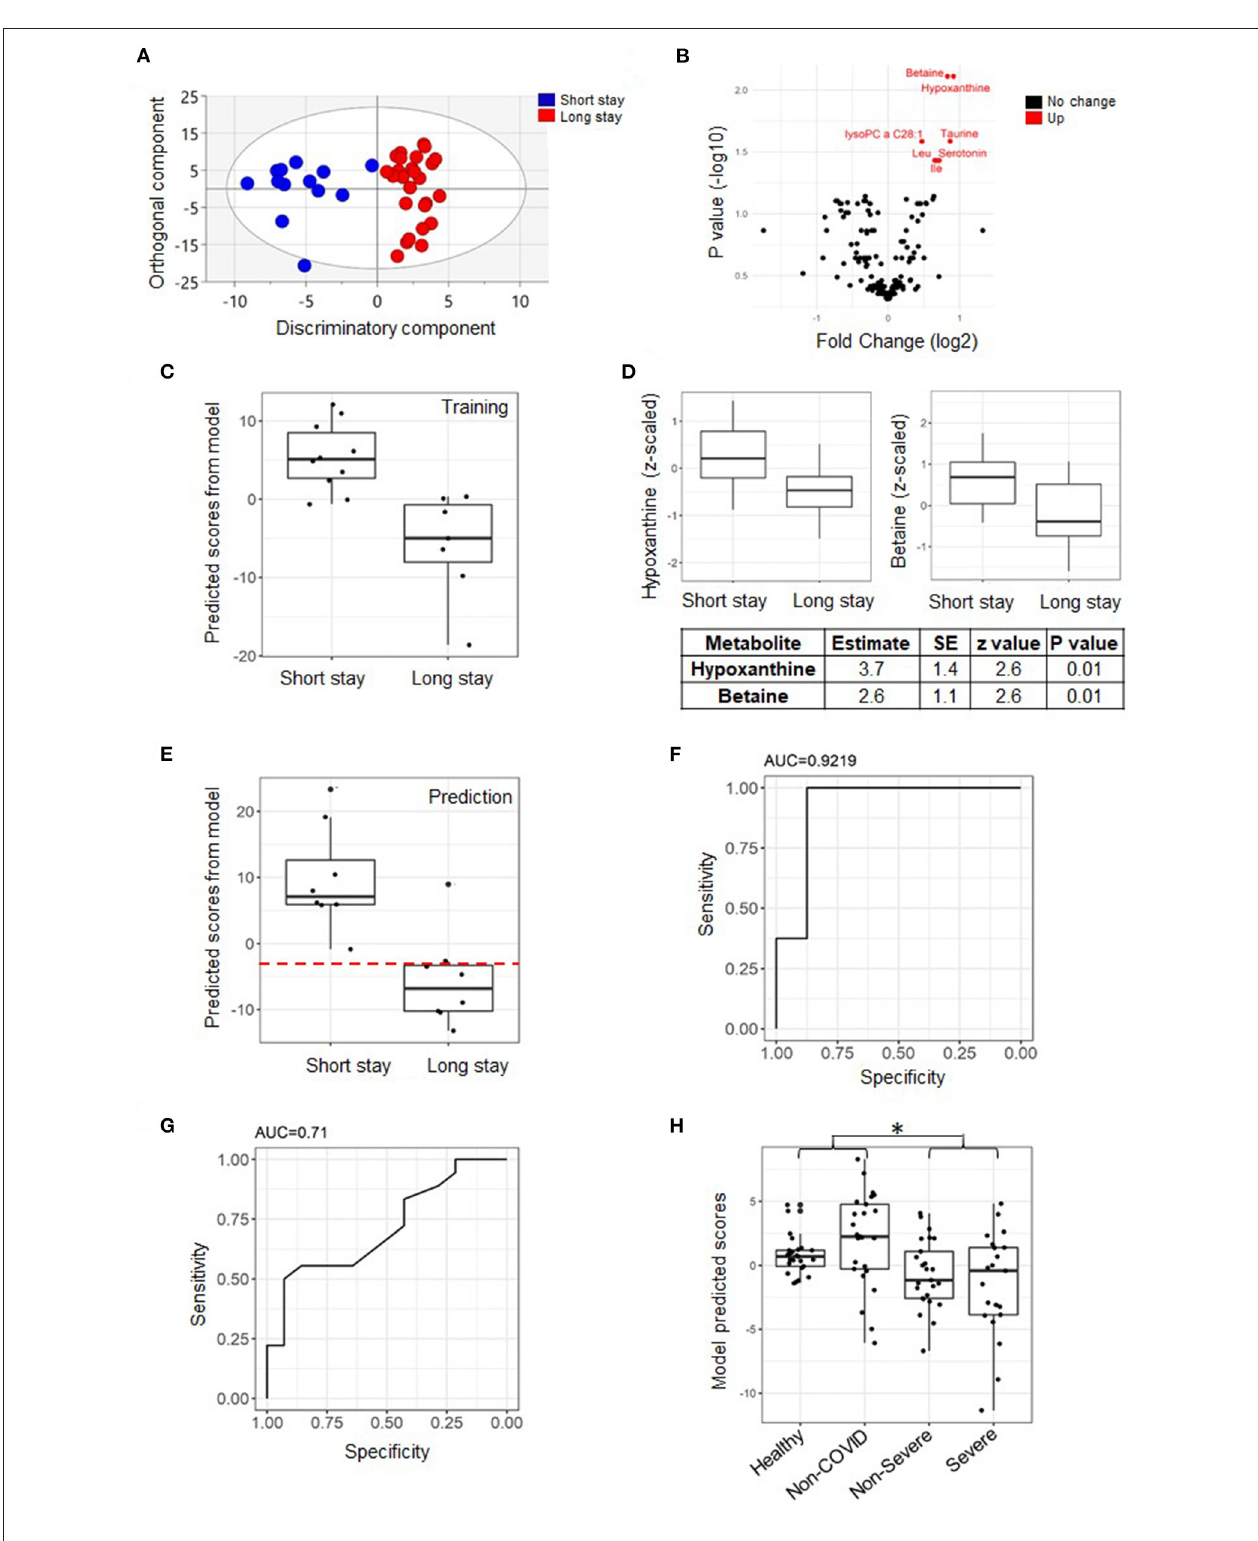
FIGURE 2 | Predictive model of length of stay (LOS) categorized into short/long based on measurement from day one. An orthogonal partial least square discriminant analysis (OPLS-DA) score plot from the whole cohort showing the class-discriminatory component ( x -axis) vs. the orthogonal confounding component ( y -axis) for long vs. short LOS groups, the discriminatory component explaining up to 86% of the variation in the Y phenotype variable (A) . A volcano plot showing significantly